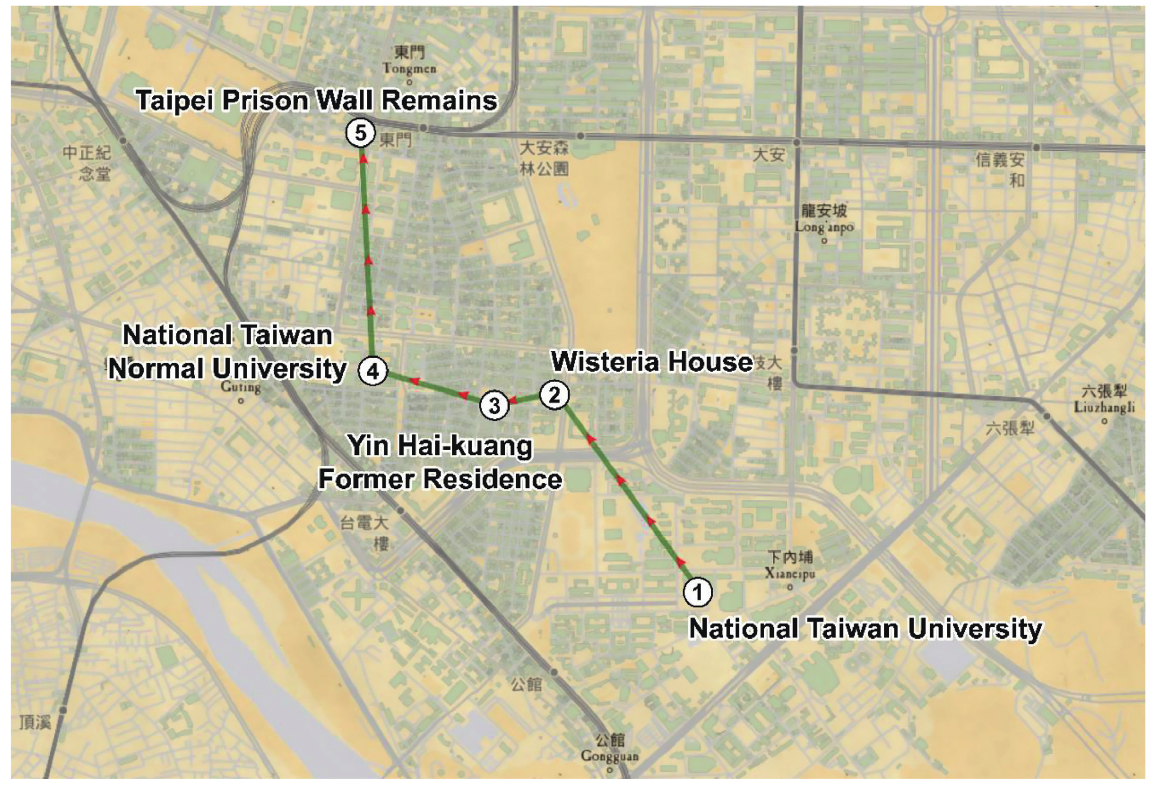
Figure 3: Taipei freedom route (B).